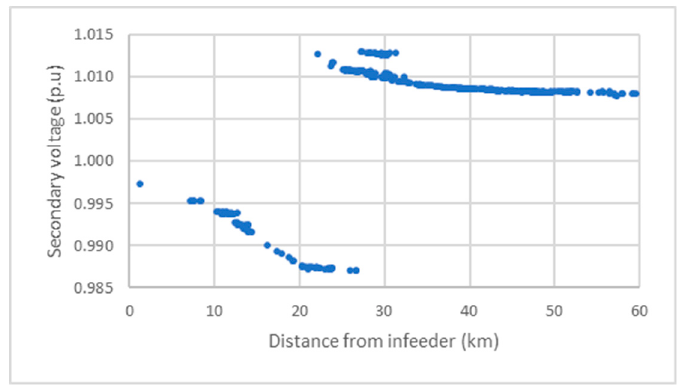
Figure 14. Secondary terminal voltage profile for MV/LV transformers for Case 2.2. The result had a better fitness than Case 2.1.